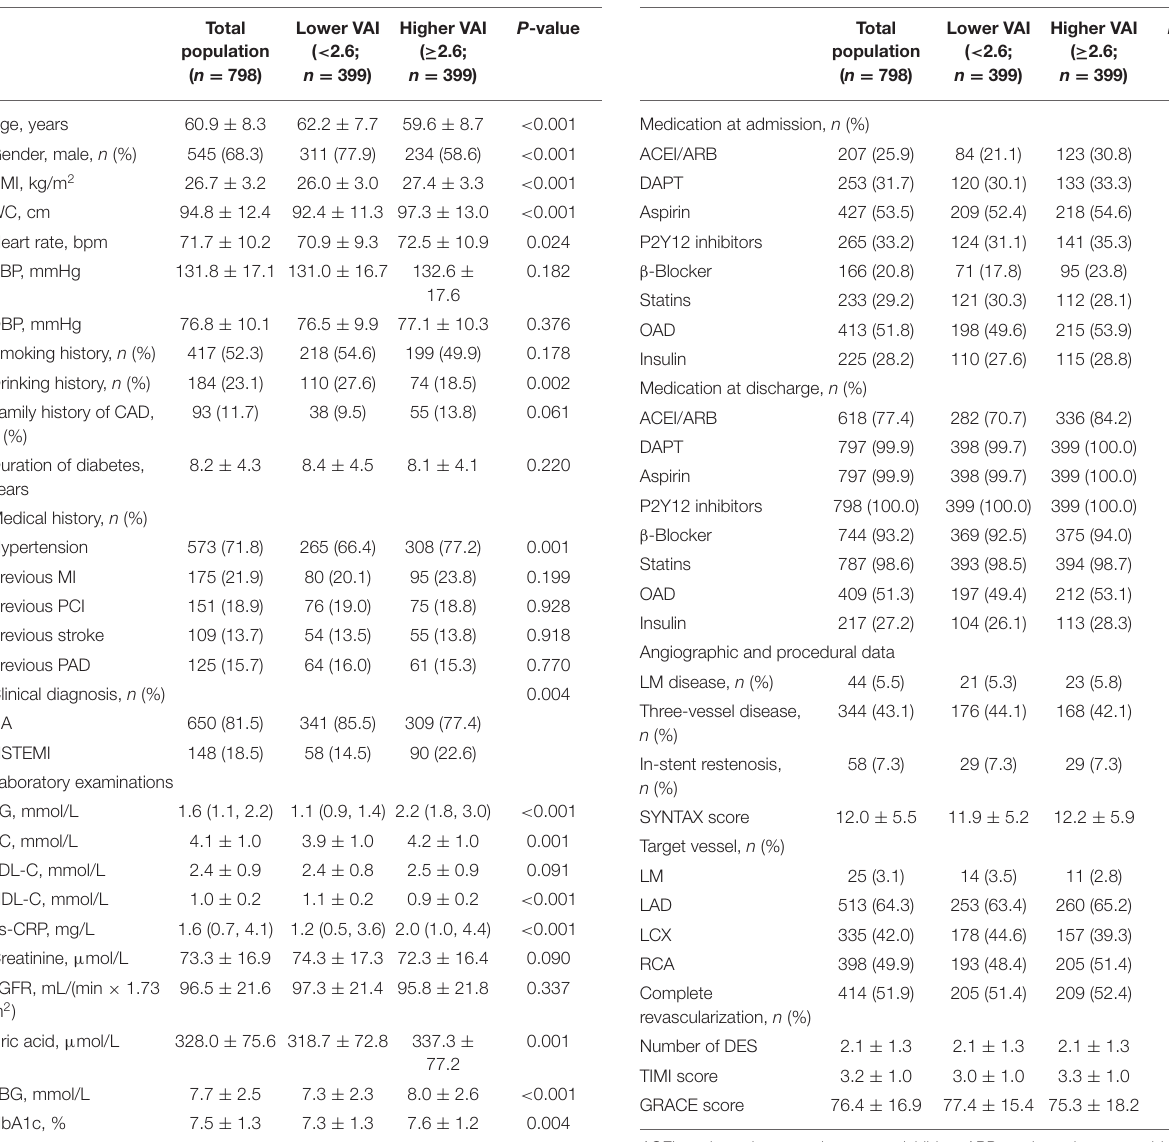
TABLE 2 | Therapeutic, angiographic, and procedural characteristics of the study